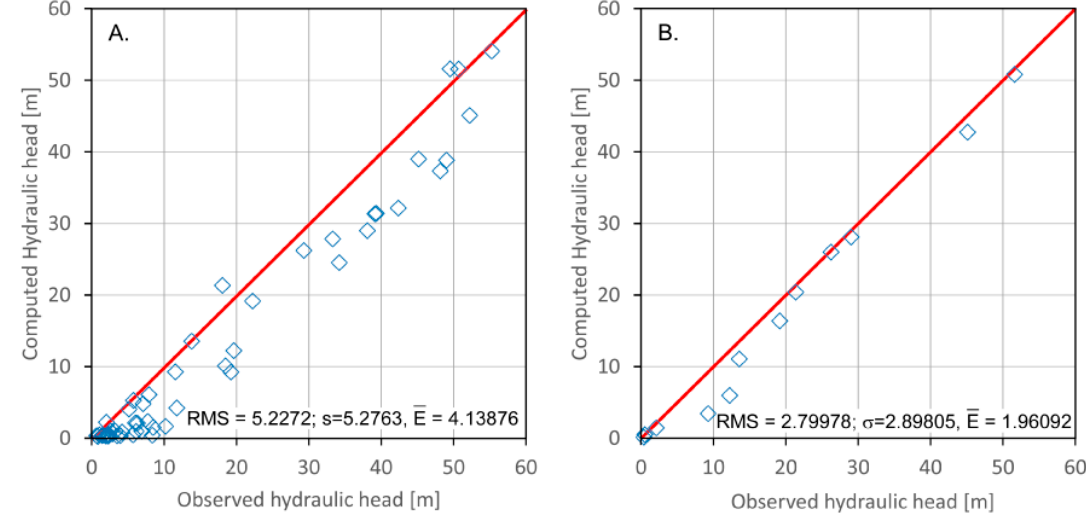
Figure 7. Diagram of the computed and observed hydraulic heads based on the simulation: ( A ) calibration and ( B ) validation. 𝐸(cid:3364) (m): Average of the absolute deviations, RMS (m): Root Mean Square error, σ (m): error standard deviation.